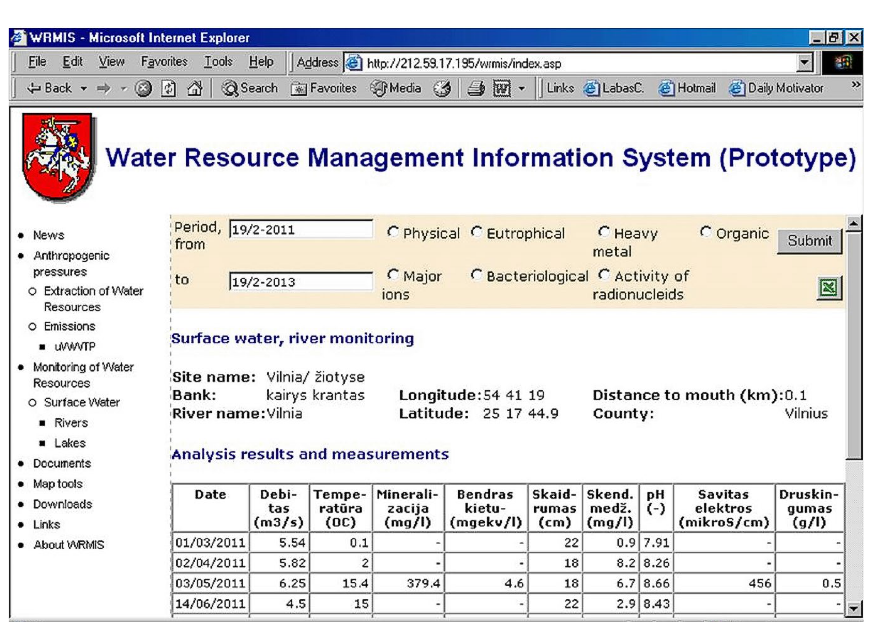
Fig. 6. WRMIS water contamination data view for the decision